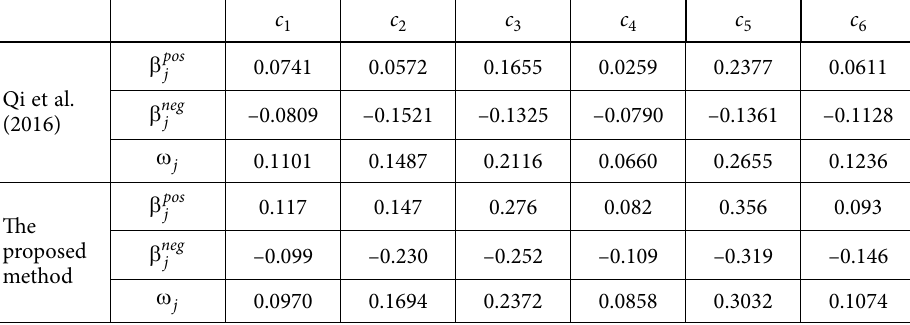
Table 12. The comparative result of the two models